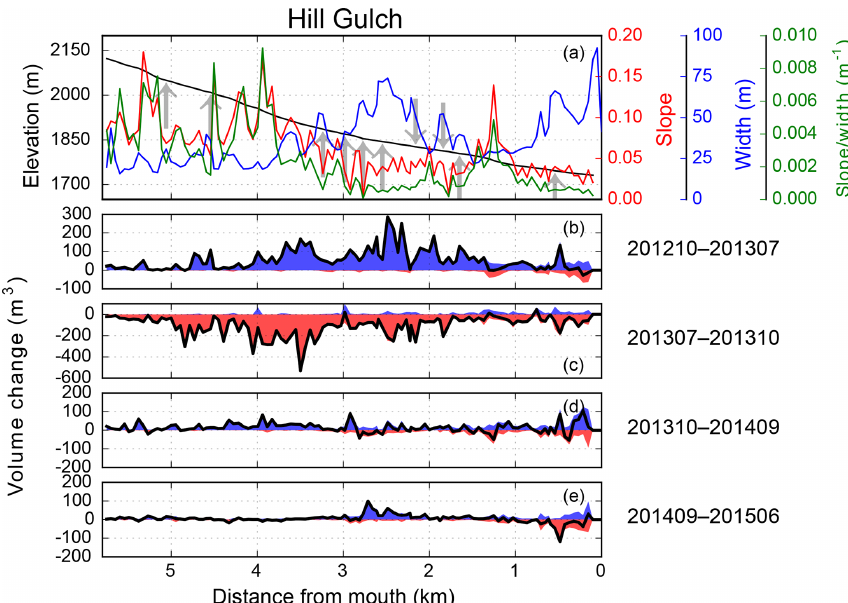
Figure 9. Longitudinal distributions in Hill Gulch of (a) elevation, channel slope, valley width and flood power, and the corresponding longitudinal changes in volume for (b) T1 (201210–201307), (c) T2 (201307–201310), (d) T3 (201310–201409), and (e) T4 (201409– 201506). Up and down arrows in (a) represent tributaries that enter the main channel from the right and left, respectively. Blue and red areas in (b) – (e) are deposition and erosion, respectively, and the black line is net volume change. See Fig. 1 for the location of the reaches being represented, and the data in (a) were taken from the 201310 lidar